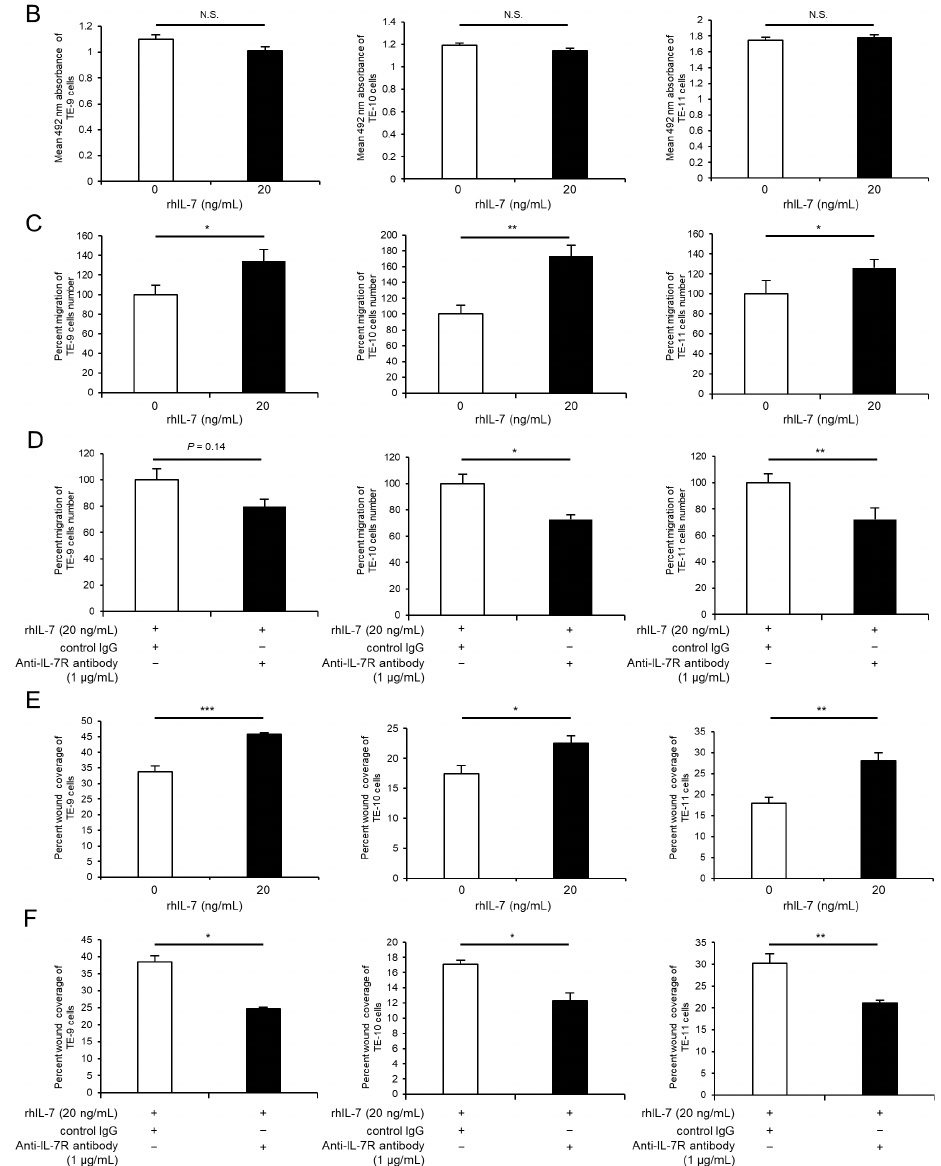
Figure 4. Exogenous IL-7 enhances the migration of ESCC cells via IL-7R without affecting cell survival or growth. ( A , B ) Cell proliferation assays were performed to investigate the effect of recombinant human IL-7 (rhIL-7, 20 ng/mL) on the survival ( A ) and growth ( B ) of TE-9, -10, and -11 cells. ( C ) Transwell migration assays were performed to investigate the effect of rhIL-7 on the vertical migration abilities of TE-9, -10, and -11 cells. The migrated cells were enumerated in four randomly selected areas. ( D ) Transwell migration assays were performed to investigate the effect of anti-IL-7R neutralizing antibodies on rhIL-7-induced vertical migration abilities of TE-9, -10, and -11 cells. Normal mouse IgG was used as a negative control. The migrated cells were counted in four randomly selected areas. ( E ) Wound healing assays were performed to investigate the effect of rhIL-7 on the horizontal migration abilities of TE-9, -10, and -11 cells. After incubation for a specific duration, the percentage wound coverage was measured and compared. ( F ) Wound healing assays were performed to investigate the effect of anti-IL-7R neutralizing antibodies on rhIL-7-induced horizontal migration abilities of TE-9, -10, and -11 cells. Normal mouse IgG was used as a negative control. After incubation for a specific duration, the percentage wound coverage was measured and compared. Data are presented as the mean ± SEM. N.S., not significant. * p < 0.05, ** p < 0.01, *** p <